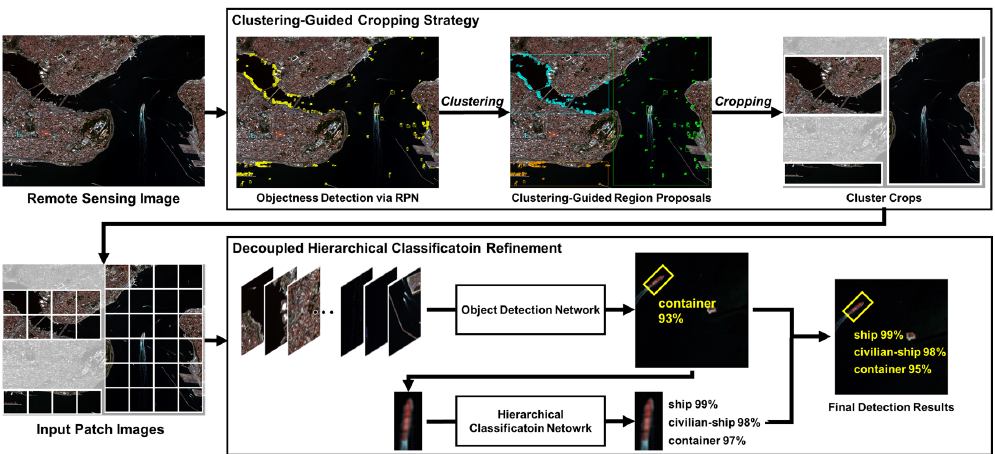
Figure 3. Overview of the proposed hierarchical multi-label object detection framework. The interesting regions are recognized for subsequent object detection through clustering-guided region